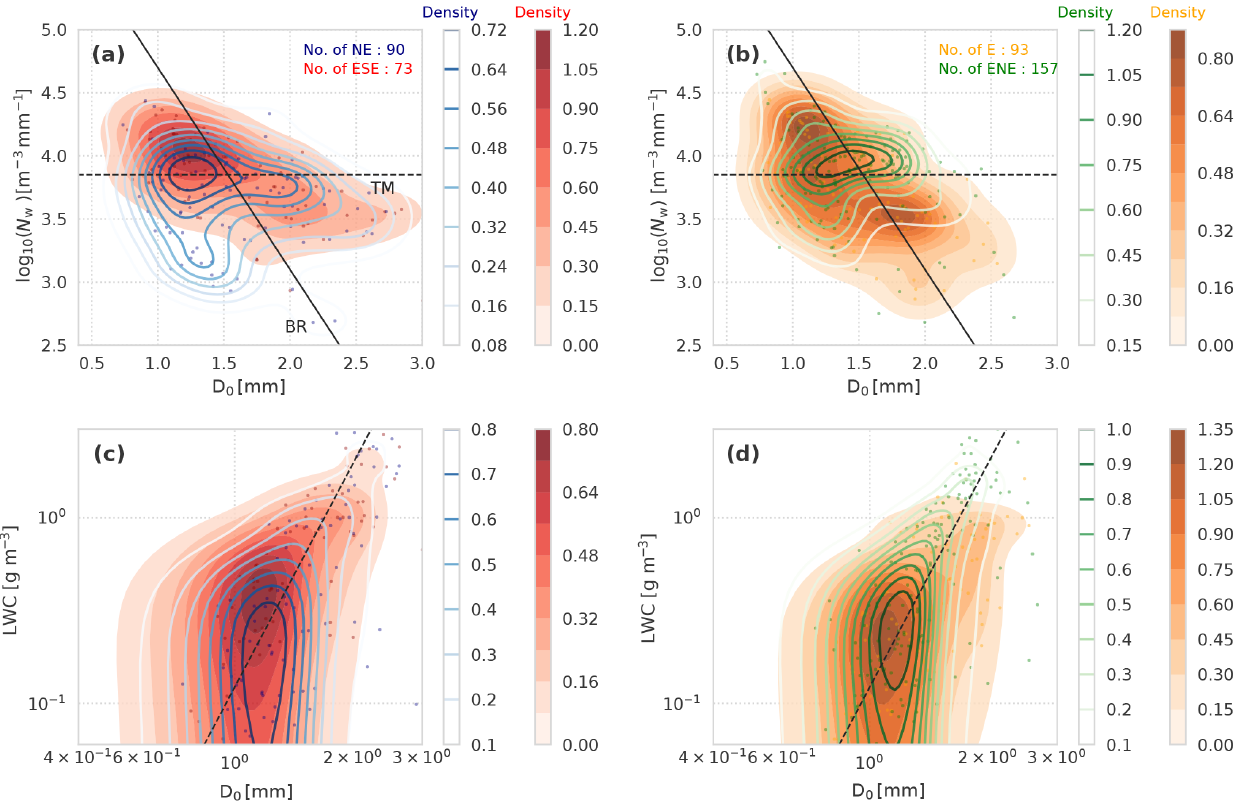
Figure 16. Scatter plots of log 10 ( N w ) versus D 0 and LWC versus D 0 for wet season DSDs on the ambient wind directions,